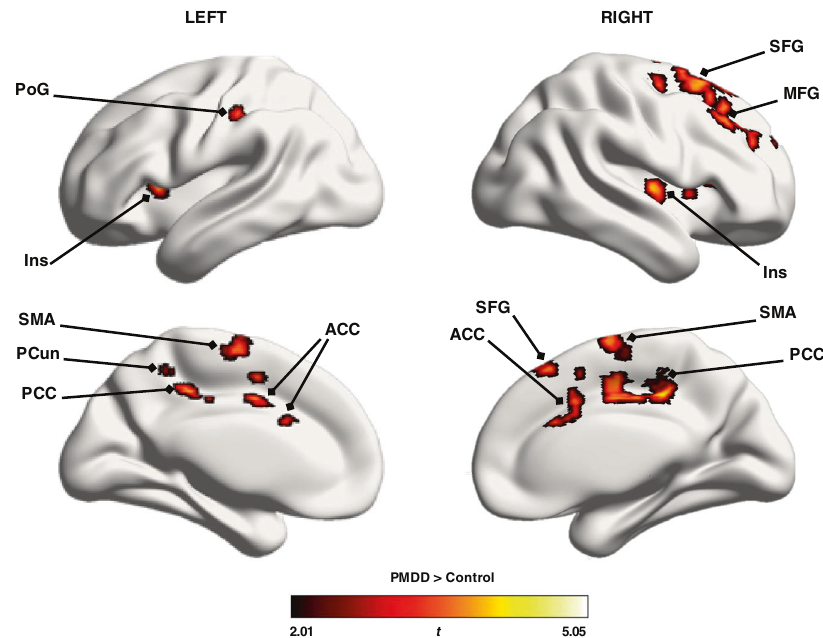
Fig. 2 Whole-brain group comparison between subjects with PMDD ( N = 29) and controls ( N = 27) of emotion-induced brain activity during the late-luteal phase of the menstrual cycle ( p FWE < 0.05, TFCE). Surface representation of signi fi cant clusters showing increased brain activity during task [Faces>Shapes contrast] in subjects with PMDD, compared with controls, during the late-luteal phase across the whole brain ( p FWE < 0.05, TFCE). ACC Anterior Cingulate Cortex, FWE Family Wise Error correction, Ins Insula, MFG Medial Frontal Gyrus, PCC Posterior Cingulate Cortex, PCun Precuneus, PoG Postcentral Gyrus, PMDD Premenstrual Dysphoric Disorder, SFG Superior Frontal Gyrus, SMA Supplementary Motor Area, TFCE Threshold-Free Cluster